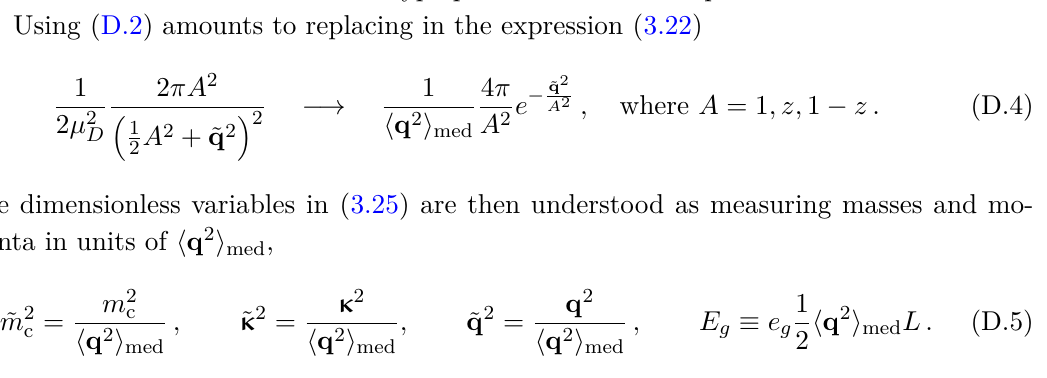
(cid:16) (cid:17) med differs from the 1 P g → c ¯ c Q 2